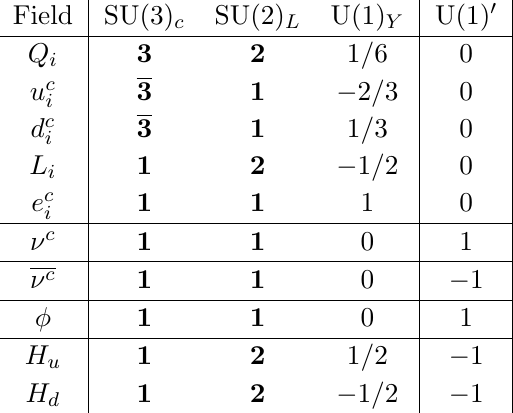
i = Q i ; L i and its CP conju-